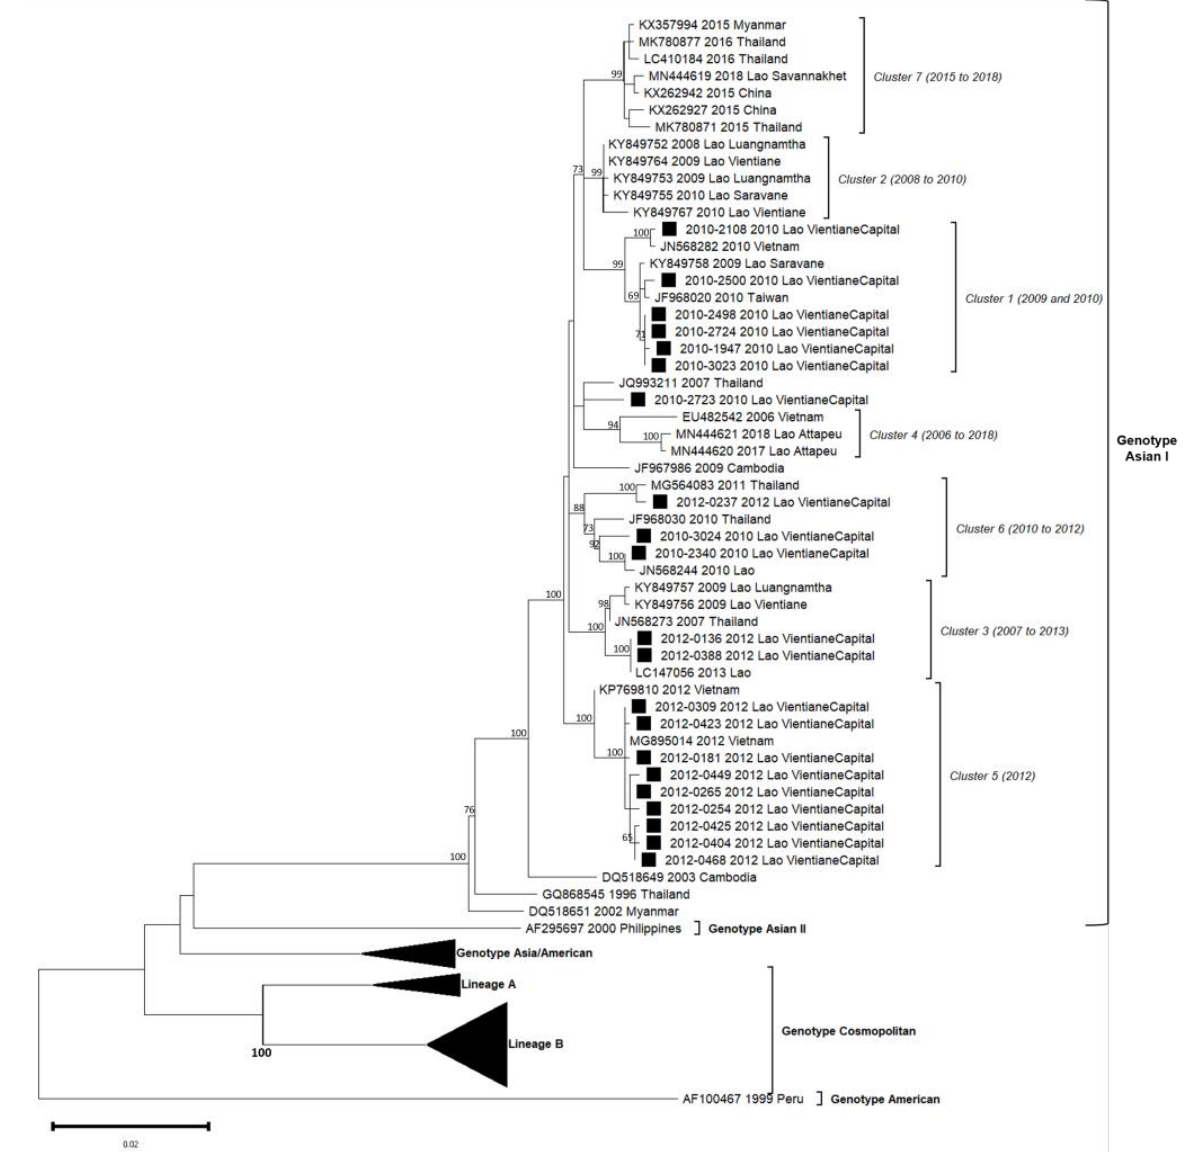
Figure 4. Phylogenetic analysis of DENV-2: 58 complete CDS protein E references of DENV-2 were selected from GenBank and aligned with the 21 DENV-2 sequences from this study (indicated with black square). Multiple sequence alignments were obtained using MAFFT version 7.023b. The unrooted phylogenetic trees were constructed using RAxML with general time-reversible plus gamma distribution substitution model and a rapid bootstrap (i.e., model GTR + I + G, bootstrap = 1000). The major genotypes, lineages, and clusters in which sequences from this study are grouped are indicated. Statistical support values of grouping (maximum-likelihood bootstrap replicates > 60%, as calculated by RAxML) are indicated at nodes of the tree. Scale bar indicates nucleotide substitution per site. Clusters in italics (C1 to C6) were predefined by Castonguay-Vanier et al., 2018, and Calvez et al., 2020, and reported in this phylogenetic tree [18,19].